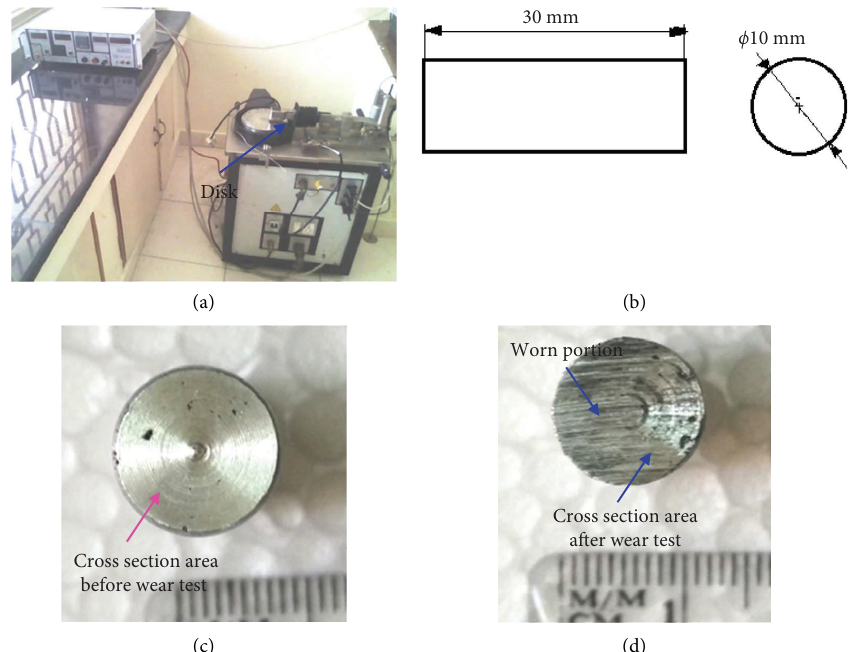
Figure 8: (a) Pin-on-disc apparatus; (b) wear test specimen design; (c) before wear test; (d) after wear